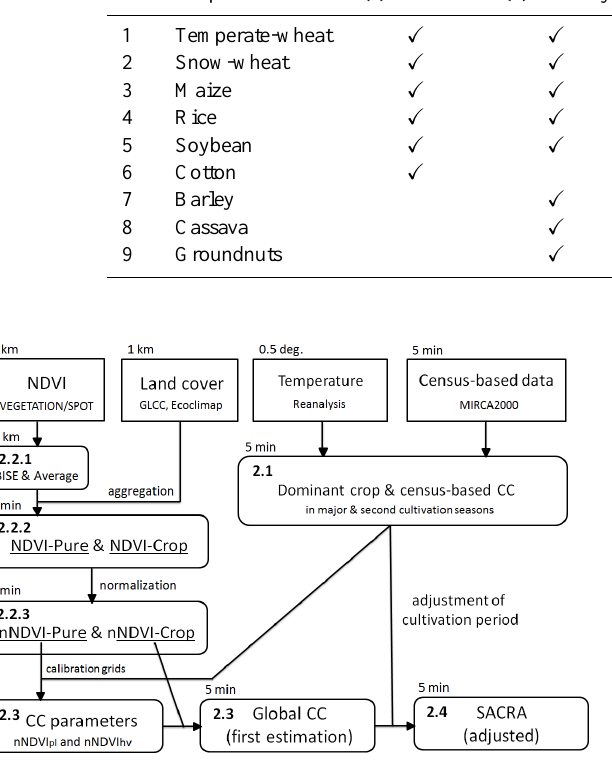
Figure 1. Data processing scheme for the production of the global satellite-derived crop calendar (SACRA). The bold numbers inside the boxes indicate the subsections in this paper where the different processing steps are described. The numbers outside the boxes in- dicate the spatial resolution of the respective data sets. The top four boxes indicate input data (Table 1), and the other boxes indicate the results from our data